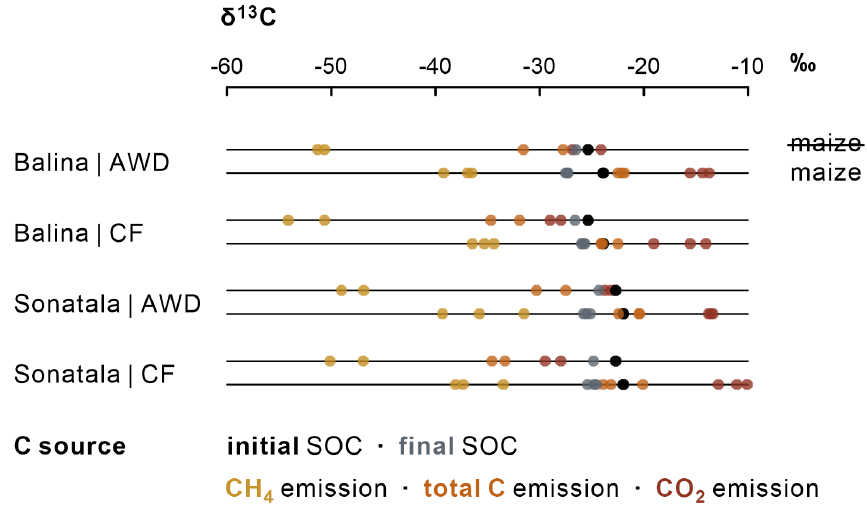
Figure 6. In the absence of maize, the overall δ 13 C signature of C emissions (values per replicate) was lower (i.e. less 13 C-enriched) under CF than under AWD ( P = 0 .